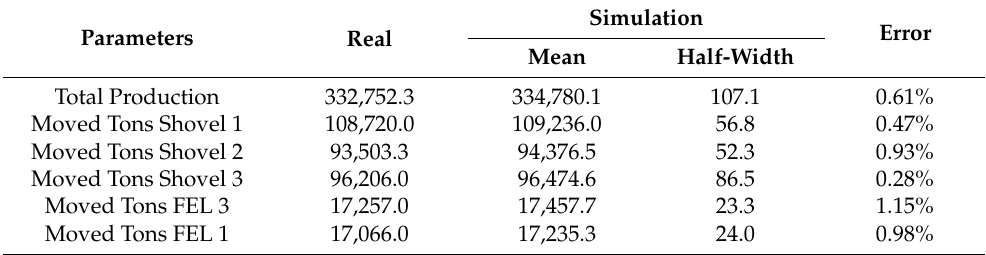
Table 6. Validation of the calibration